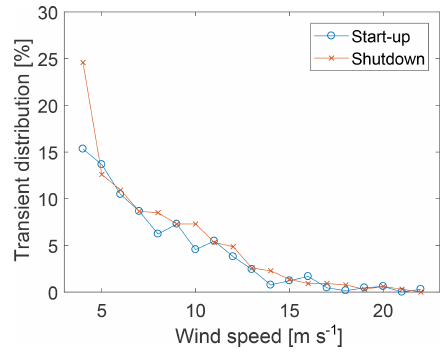
Figure 17. Estimated normalized bearing lifetime within wind farm for normal operation including start-up and shutdown events.